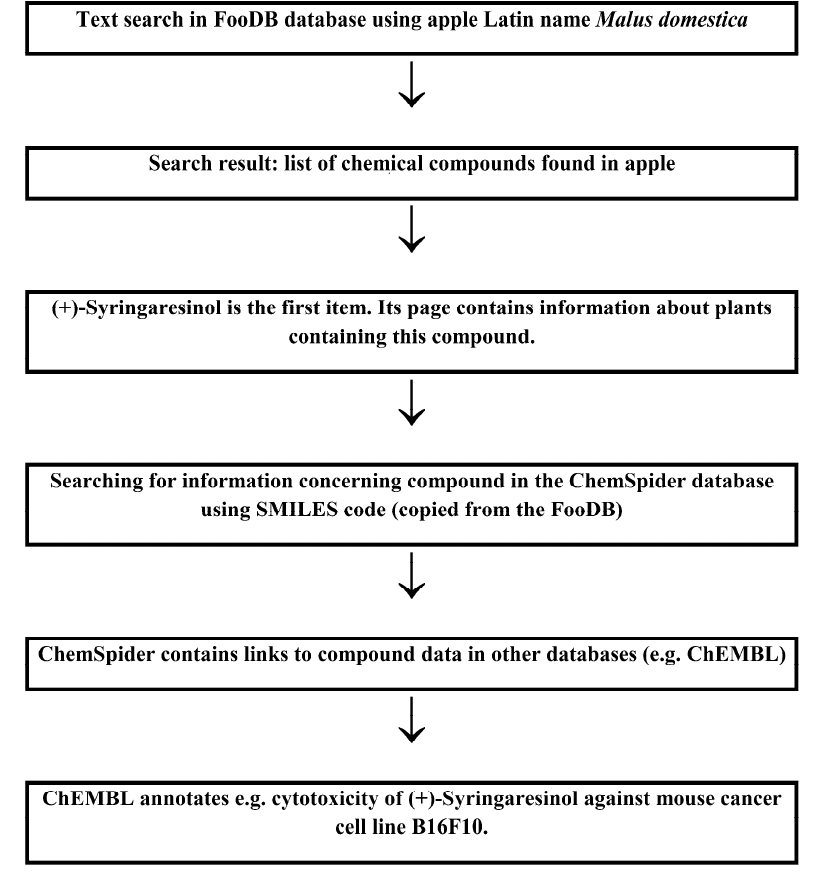
Figure 1. Possible search scheme aimed at finding the anticancer activity of compounds derived from apples ( Malus domestica ) using (+)-Syringaresinol as an example.